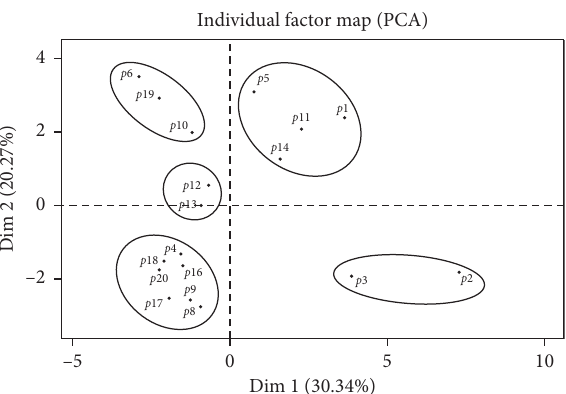
Figure 3: Individual factor map obtained from the PCA of data about the composition of Pinus nigra essential oils from four subspecies. lar: laricio , nig: nigra, salz: salzmannii , pall: